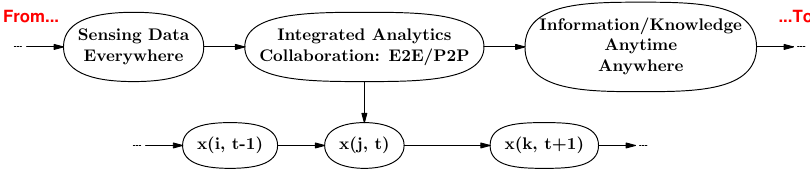
Figure 2. Architecture of the collaborative sensing intelligence (CSI) framework. From the massive data from industrial ecosystems, to mined information/discovered knowledge, which can be used in algorithm design to solve industrial problems. [..., x ( i , t − 1 ) , x ( j , t ) , x ( k , t + 1 ) ,...] is the state series relating to “location” and “time”, which is used in the collaborative analysis that is based on different state data from different equipment. E2E denotes equipment-to-equipment collaboration, and P2P is for